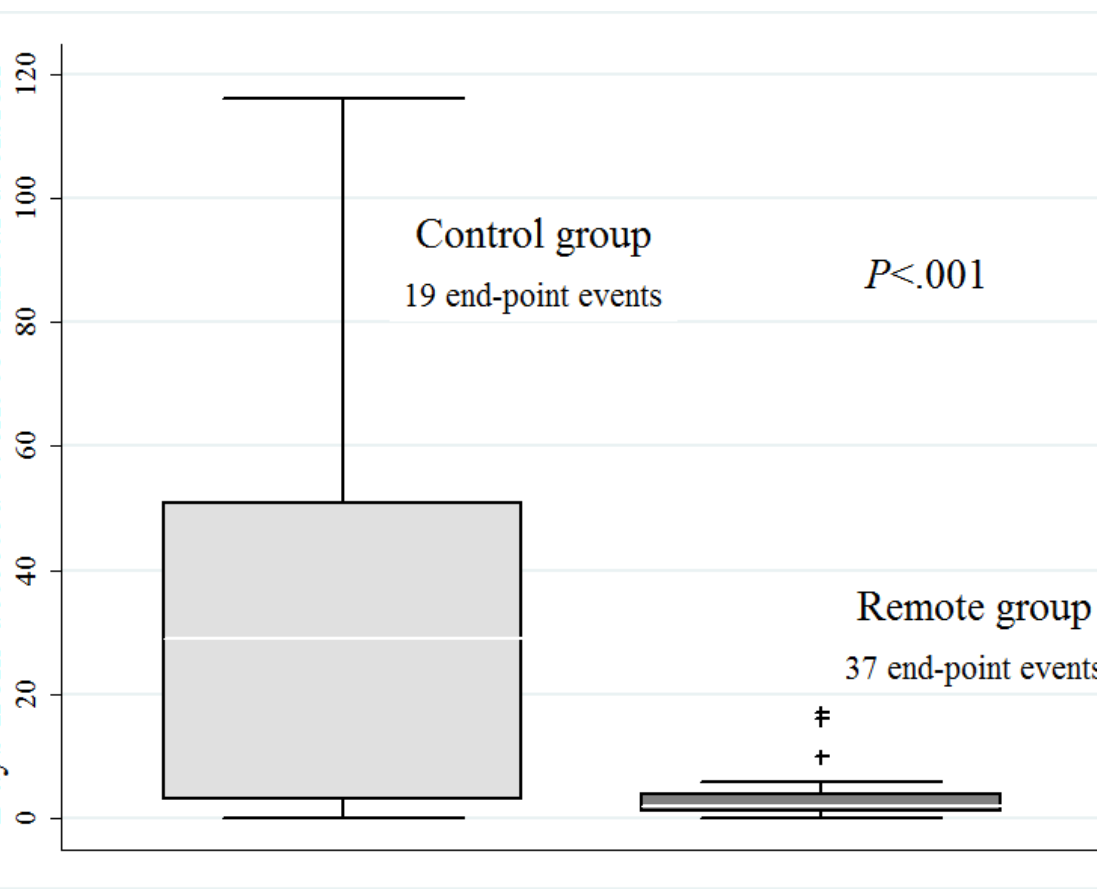
Figure 4. Time from device events to clinical decisions for the phase 1 primary end-points (19 in Control group and 37 in Remote group); box-and-whisker plots show the quartiles with the medians labeled, and the whiskers extended to the lower and the upper adjacent value; plus symbols show the outside values.